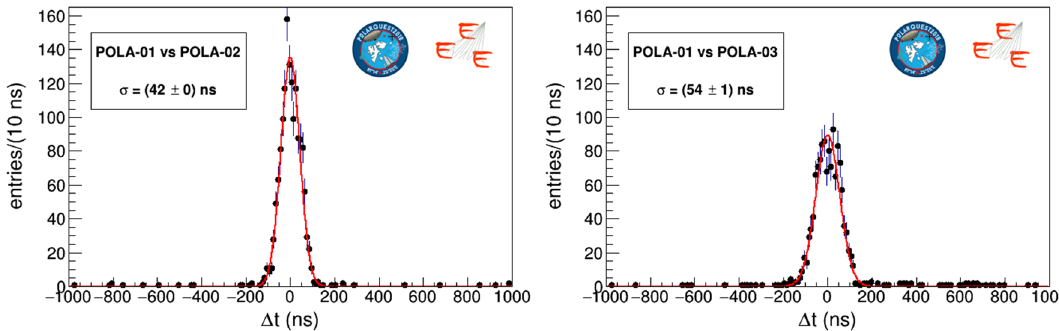
Fig. 9 Time coincidence peaks of POLA-01/POLA-02 (left) and POLA-01/POLA-03 (right). Data were taken on June 17, 2018 and correspond to approximately 2.5 h